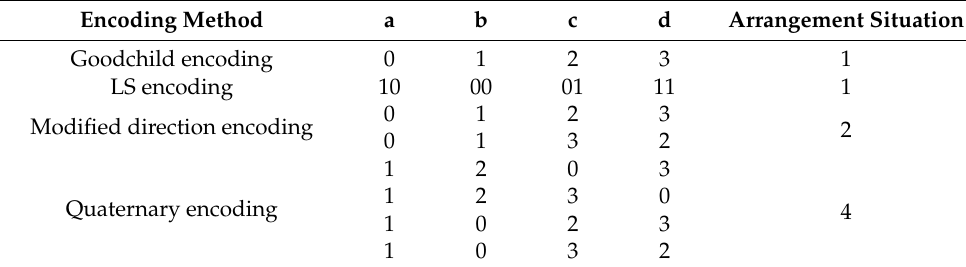
Table 2. Directivity of QTM encoding.